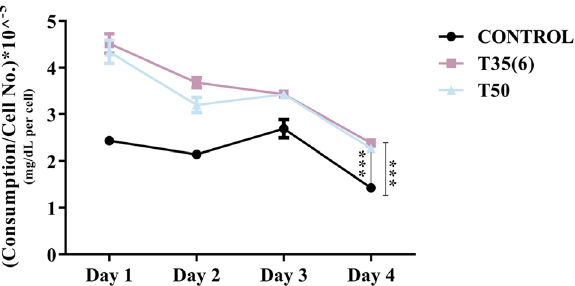
Figure 5. Rate of glucose consumption per day of normalized number of MCF-7 cells. Comparisons were performed between control untreated MCF-7 cells with tamoxifen resistant cells produced from the first (T50) and second approaches T35(6). (P*** <